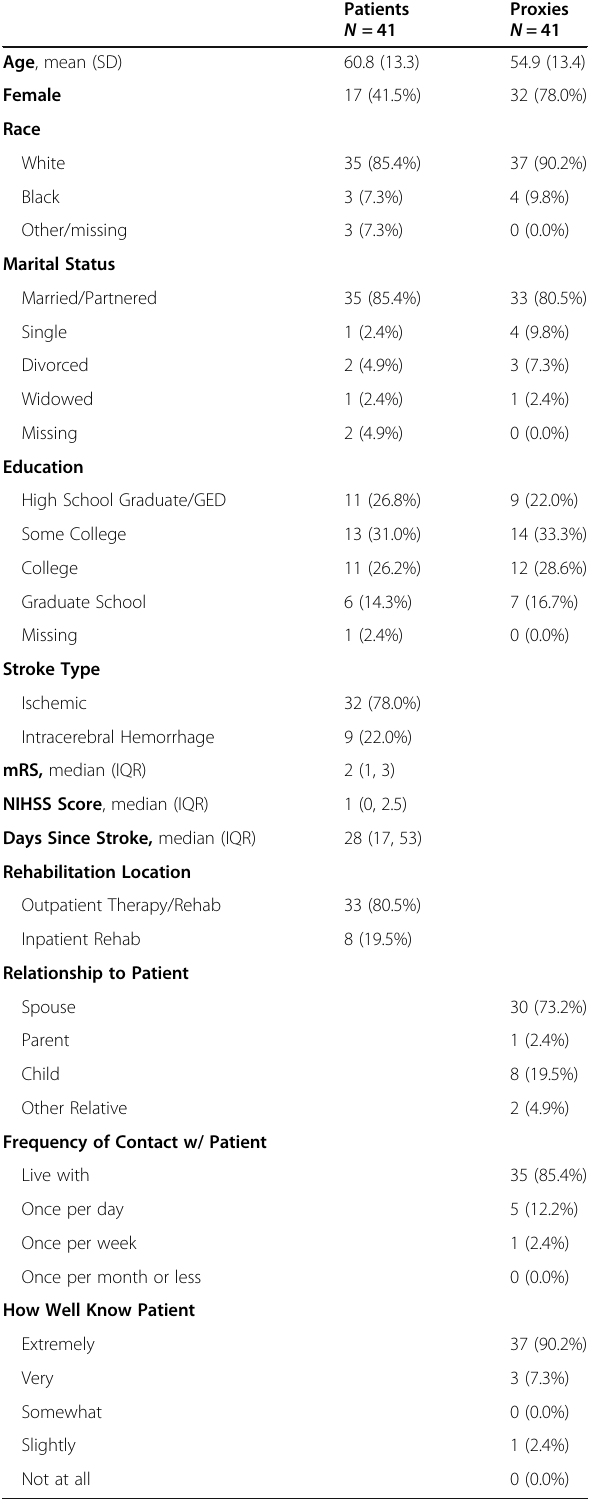
Table 1 Baseline characteristics of patients and